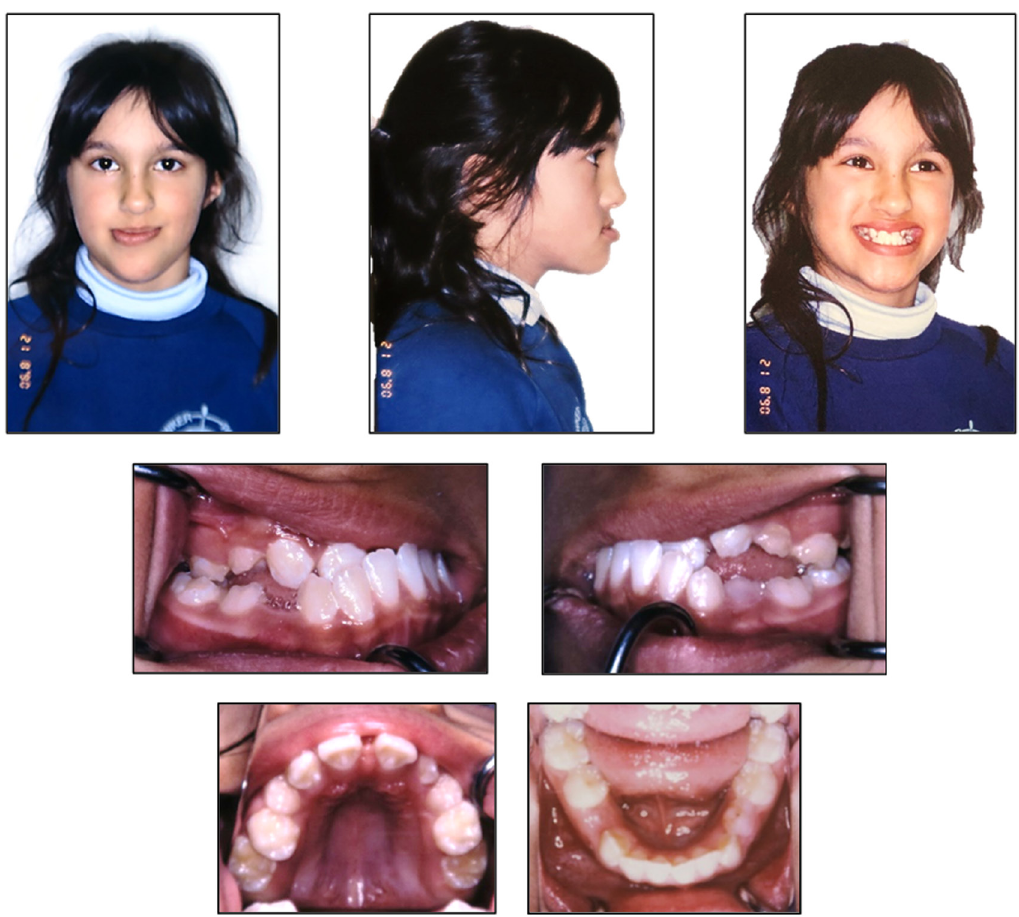
Figure 1. Pre-treatment